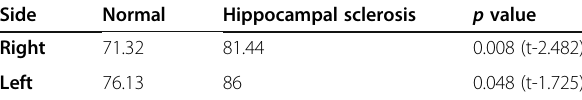
Table 3 Mean T2 relaxometry of hippocampal sclerosis in comparison with normal hippocampus in patients with focal onset seizures with impaired awareness Side